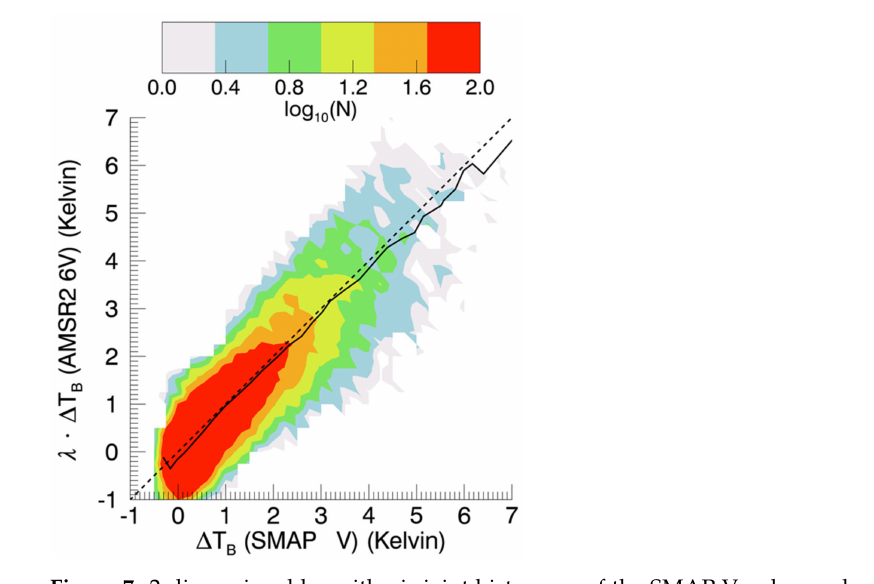
λ · ∆ T B,0 (AMSR2 6V) for the ∆ T B,0 (6V) is the